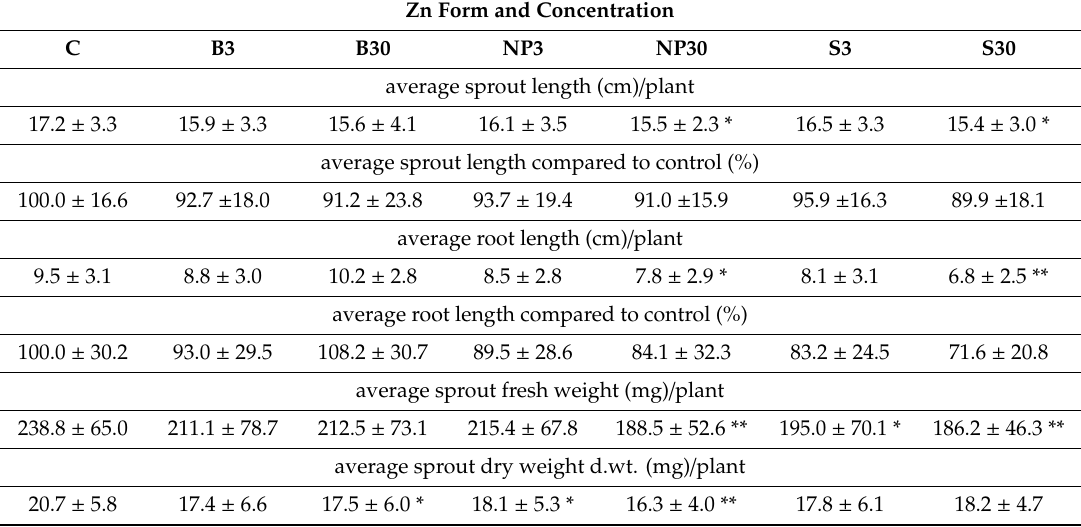
Table 1. The average length of the longest sprout and root of barley ( Hordeum vulgare L.) plants, and the average fresh weight and dry weight of sprout biomass after 10-days cultivation. The data represent absolute and relative mean values ± SD of three independent measurements with seven plants each. Zinc was applied in three di ff erent forms (bulk, nano-sized, and dissolved) and two concentration levels (3 and 30 mmol Zn kg − 1 ). For characteristics of C, B3, B30, NP3, NP30, S3, S30, see Table 3. Zn Form and